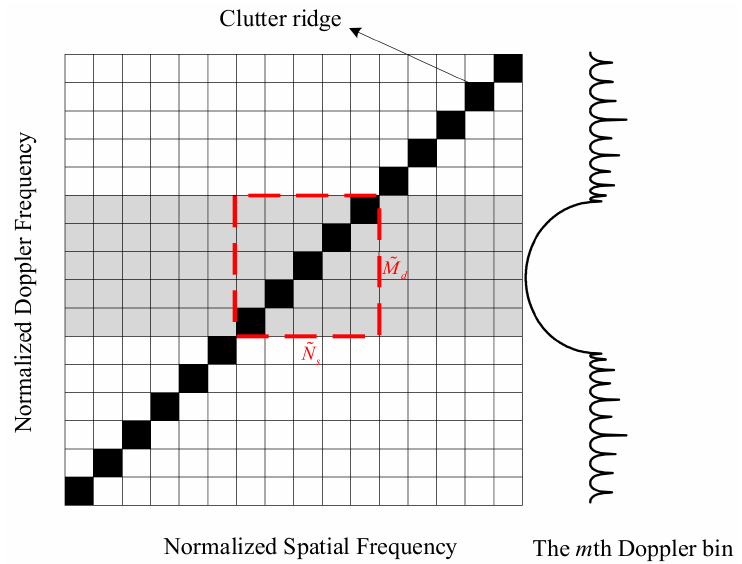
Figure 4. Illustration of local grids